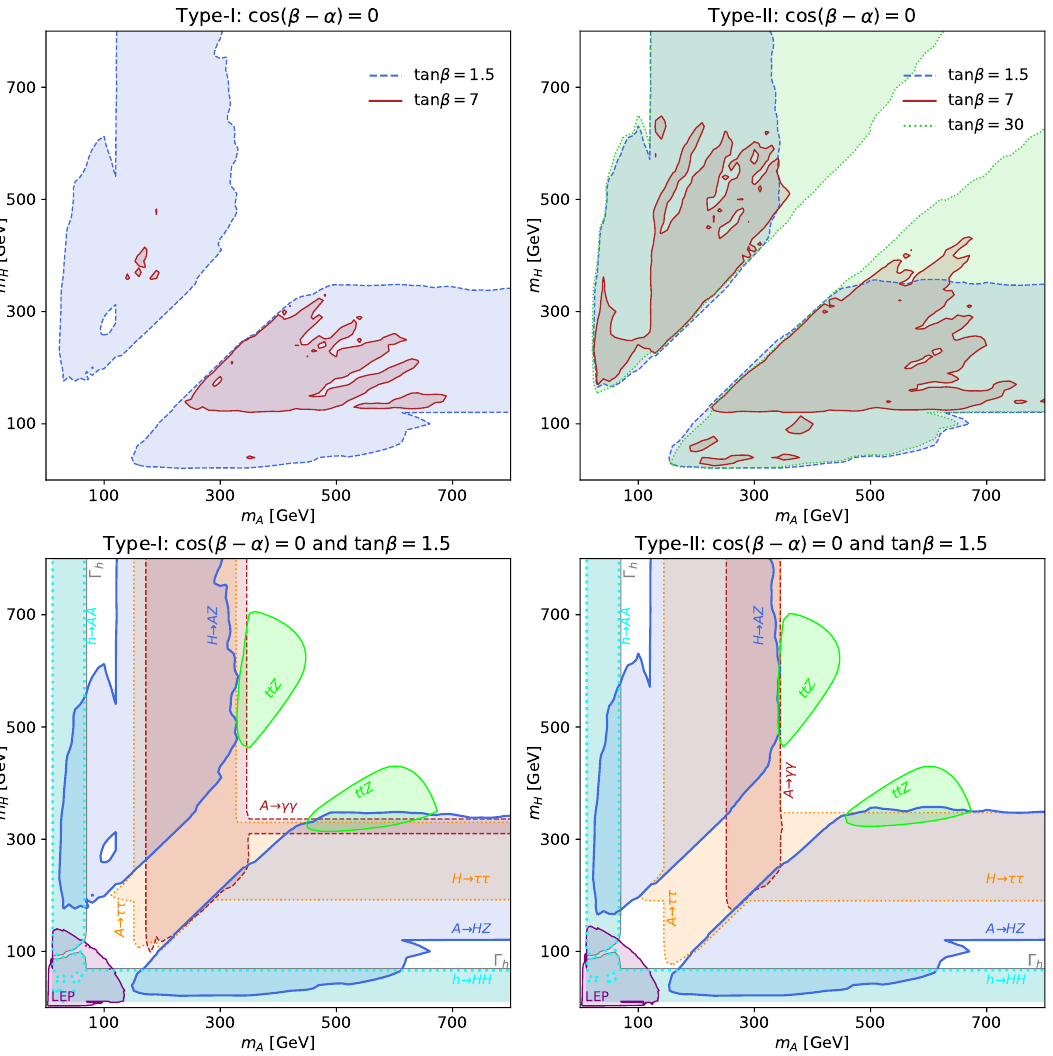
Figure 2 . Constraints on the Type-I (left panel) and the Type-II (right panel) 2HDM in m A vs. m H plane. Top: parameter space excluded at 95% C.L. by the A=H ! HZ=AZ search in the alignment limit, c (cid:12) (cid:0) (cid:11) = 0, for t (cid:12) = 1 : 5 (blue), 7 (red) and 30 (green). Bottom: constraints at 95% C.L. for c (cid:12) (cid:0) (cid:11) = 0 and t (cid:12) = 1 : 5 from LHC searches for A=H ! HZ=AZ (blue), A=H ! (cid:28)(cid:28) (dotted orange), A=H ! (cid:13)(cid:13) (dashed brown), h ! AA=HH (dotted cyan) and ttZ production (green)